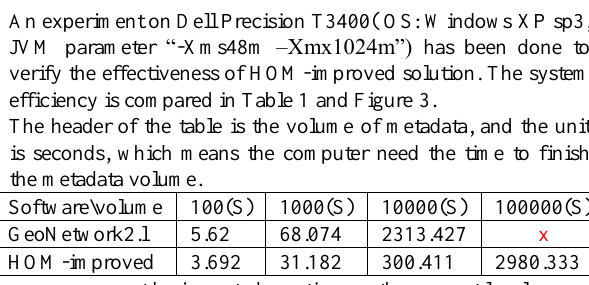
Table 1. Import efficiency contrast on different amount of metadata